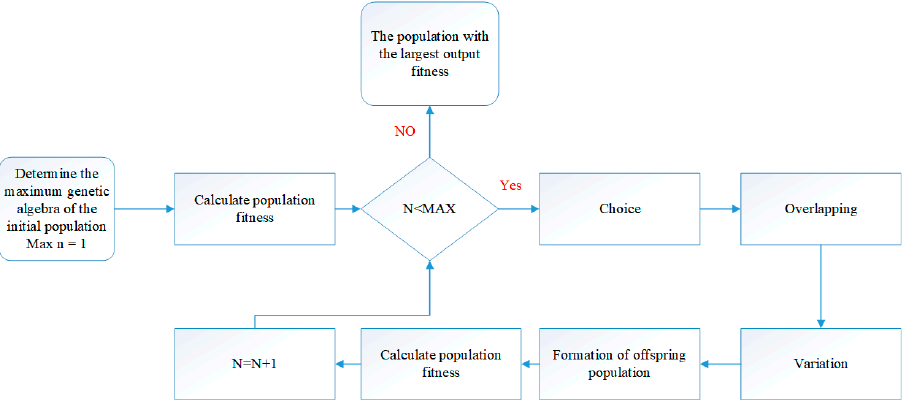
Figure 7. Flow chart of genetic algorithm.